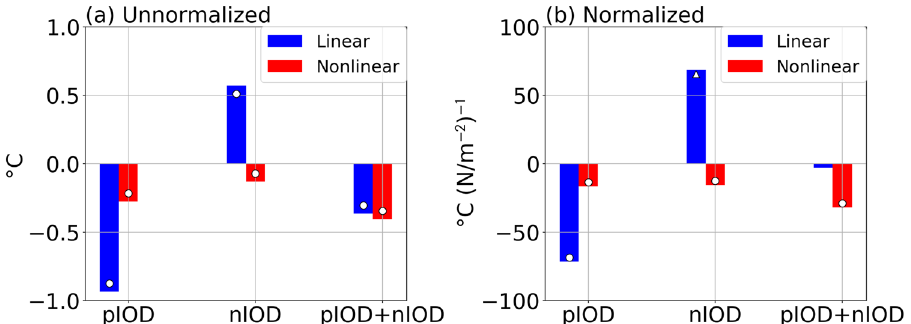
Figure 3. Decomposition of the horizontal advection term. ( a ) Linear (blue) and nonlinear (red) horizontal advection terms (in °C) integrated over the development phase for the pIOD (left) and the nIOD (middle). Their sums are also presented (right). ( b ) As in ( a ), but normalized by EQUINOO. The circles (triangles) indicate anomalies significant at the 95% (90%) confidence level by a two-tailed t